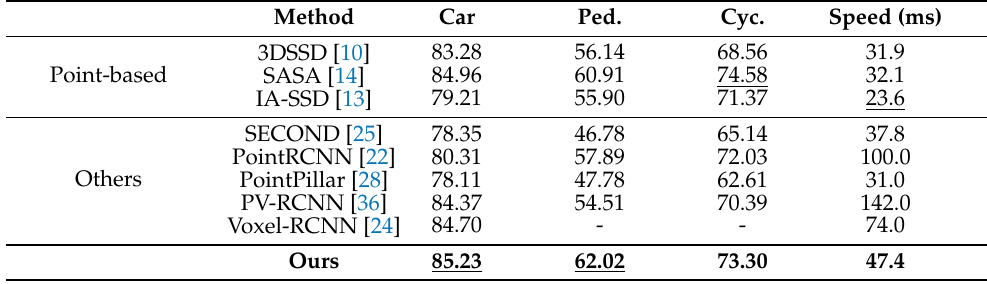
Table 8. Runtime and performance of different methods on KITTI validation set. The mean average precision is measured with 40 recall positions AP 40 . All results are reproduced by OpenPCDet [53] implementation. The results of our SGSSD are shown in bold, and the best results are